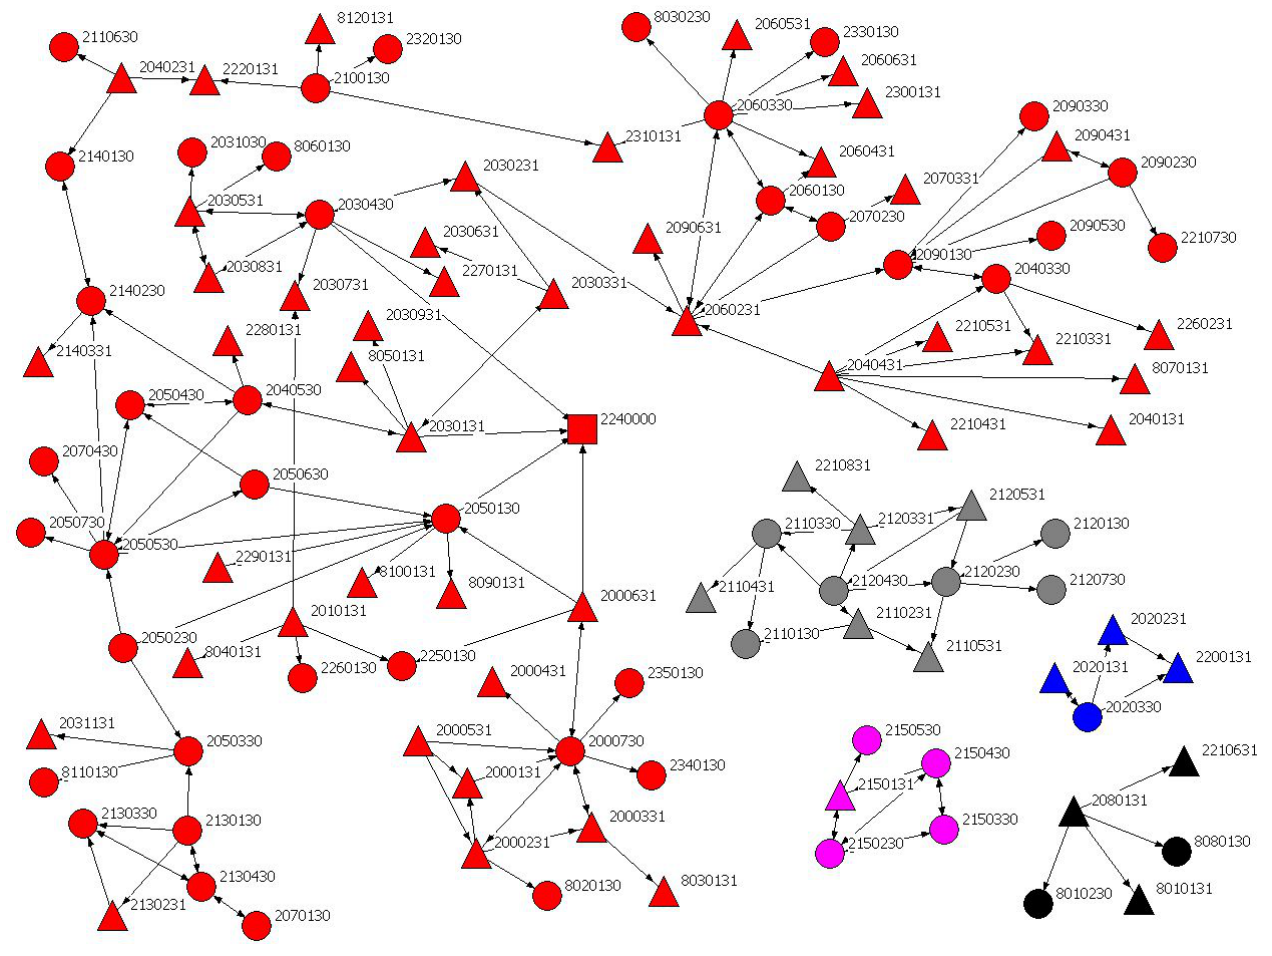
Fig. 2 . Seed exchange network in Vall Fosca (Catalan Pyrenees). Note: Nodes (111 gardeners who participated in seed exchanges) are shaped by the sex of the node (triangle for men, circle for women, and a square for a local seed bank), and colored to indicate different network components. The number next to the node corresponds to the identification number of the primary garden tender (the first three numbers for village of residency). Edges arrow represents the direction of the